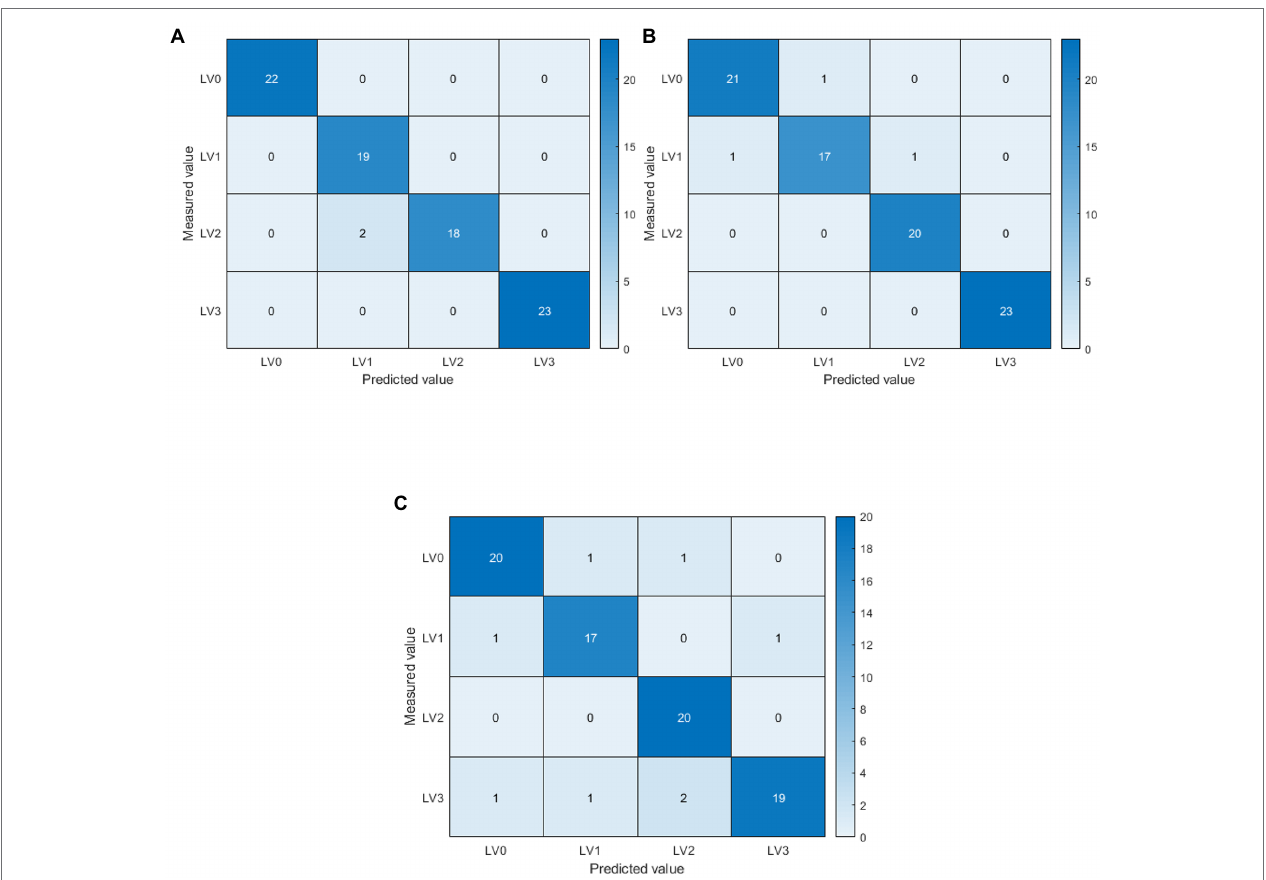
FIGURE 8 | Confusion matrix based on ElasticNet+TFs modelling. LV0: Healthy (no disease spot); LV1: Level 1 (disease spot area less than 1% of leaf area); LV2: Level 2 (disease spot area of 1%–5% of leaf area); LV3: Level 3 (disease spots covering more than 5% of the leaf area). The diagonal line is the number of samples judged to be correct. (A) ElasticNet+TFs-adaptive-weight immune particle swarm optimization extreme learning machine (AIPSO-ELM), (B) ElasticNet+TFs-support vector machine (SVM), and (C)